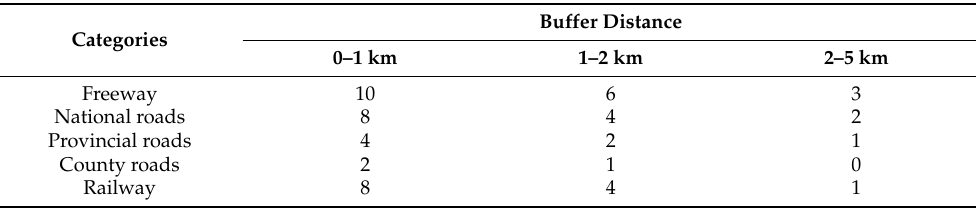
Table 1. Disturbance scores of roads and railways to the ecosystem in the Qilian Mountain Nature